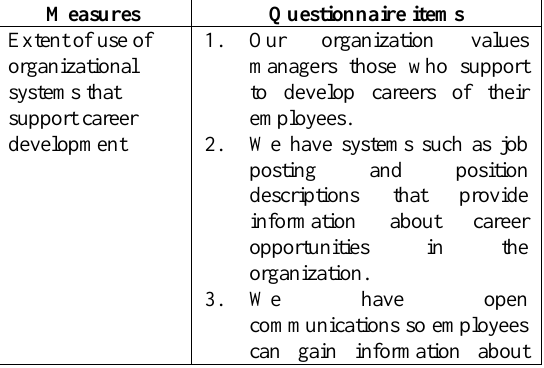
Table 1: Scale of Career Development Culture